Question: Express in one sentence what the figure is showing.
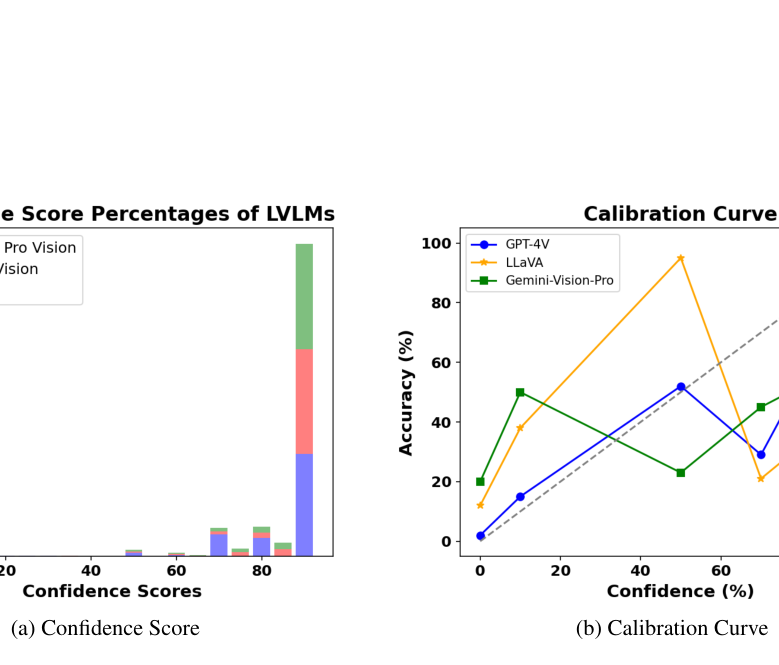
Answer: Confidence score and it’s calibration